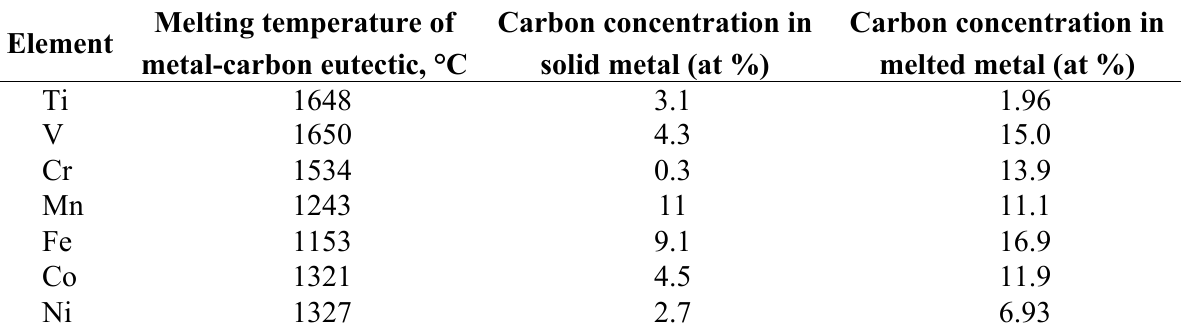
Table 2. Solubility of carbon in metals